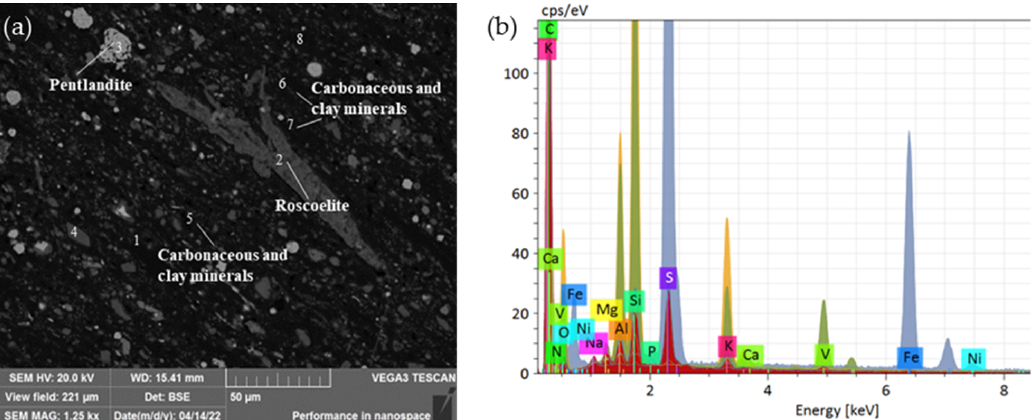
Figure 6. Vanadium occurrence in the ore: ( a ) Scanning electron microscope image of roscoelite and carbonaceous clay minerals in stone coal, 1-8 were the analysis positions of the energy spectral; ( b ) EDS analysis of the minerals containing vanadium. Table 5. Spectral microdomain composition analysis of vanadium mica and carbonaceous clay min- erals at positions 1-8 in Figure 6a.